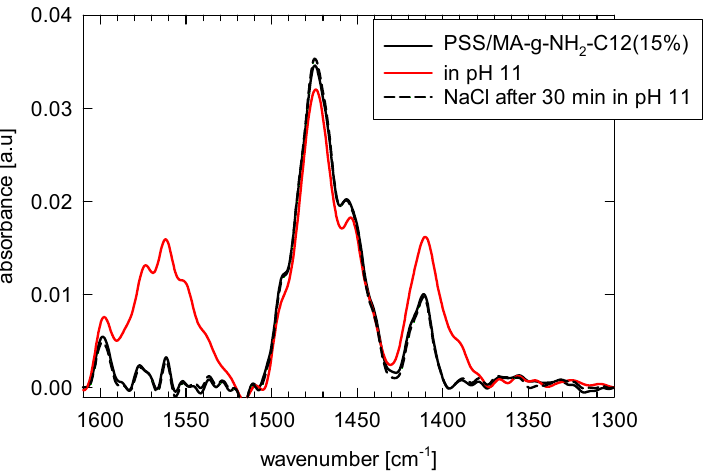
Figure 7. The example of the FTIR spectra of (PDADMAC/PSS) 4 PDADMAC multilayer film with adsorbed PSS/MA-g-C 12 NH 2 (15%) as the last layer during the exposure to the alkaline environment pH = 11. The dashed line illustrates the spectrum obtained after exposure for 30 min at pH = 11 and flushing with 0.15M NaCl solution pH = 7.